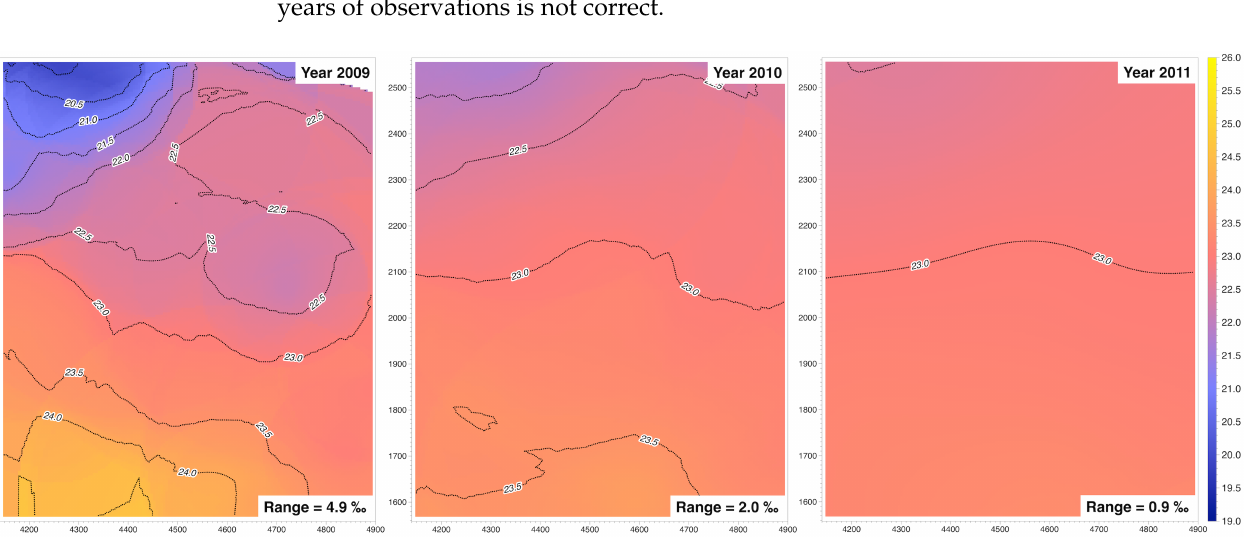
Figure 18. 2009, 2010, and 2011 δ 18 O isoscapes as sheets of the model. Plots prepared with Data- Graph [81] from exported geotiff